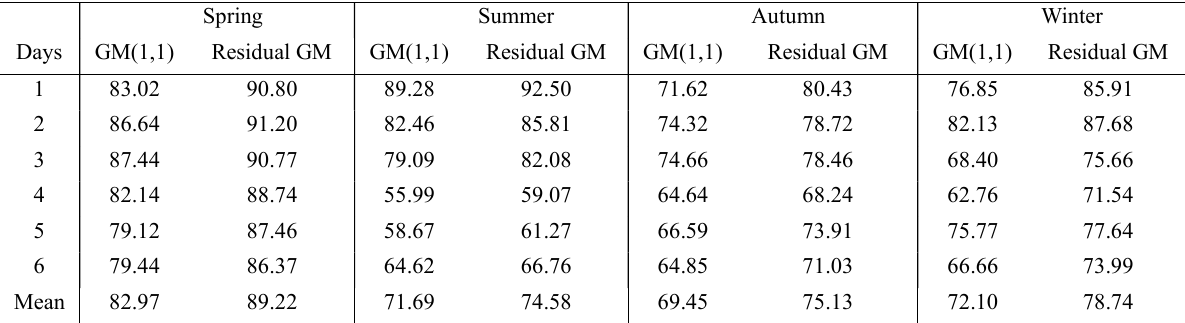
Table 2. Daily average relative accuracy of four models in mid-latitudes P % Spring